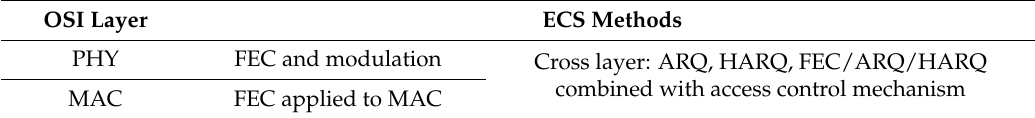
Table 4. ECS classification based on Open Systems Interconnection (OSI)